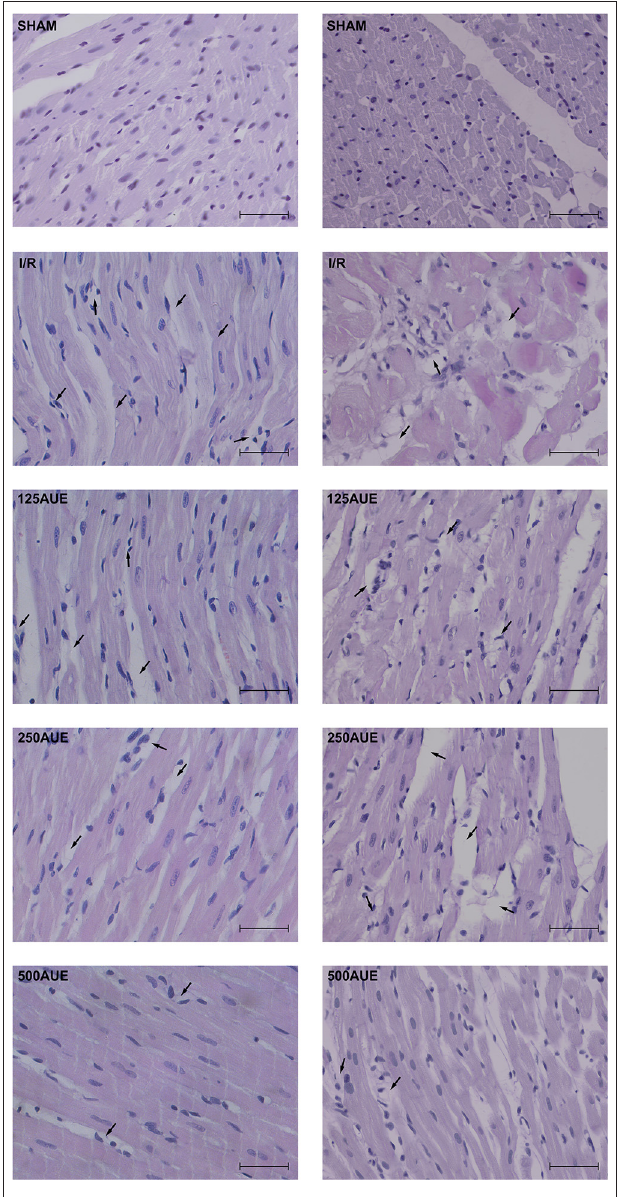
FIGURE 6 | Representative photographs (magnification × 40; bar = 25 µ m) of hematoxylin and eosin staining of cardiac muscle tissue.